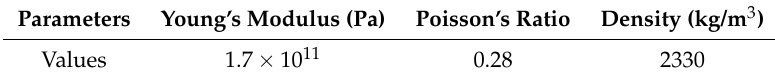
Table 3. Model parameters for FEM simulations.